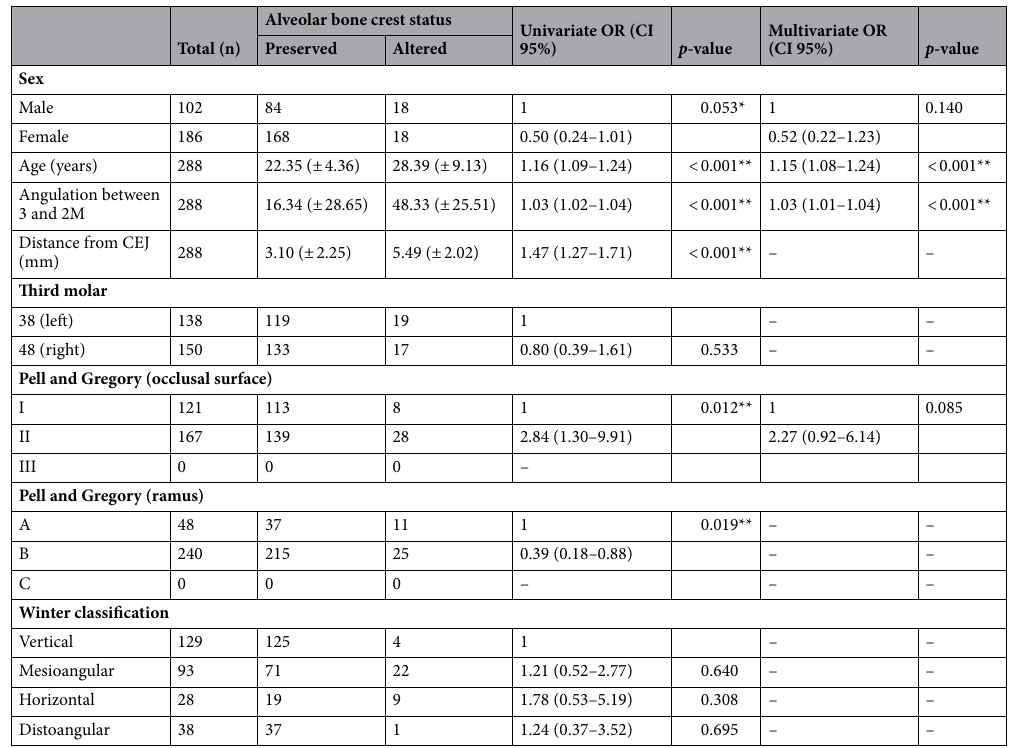
Table 1. Frequency distribution plus univariate/multivariate logistic regression model: Bone crest status and independent variables. Data are presented as n of subjects (%) or as mean ± SD. OR odds ratio, CI 95% 95% of confidence interval. *p < 0.20; **p <